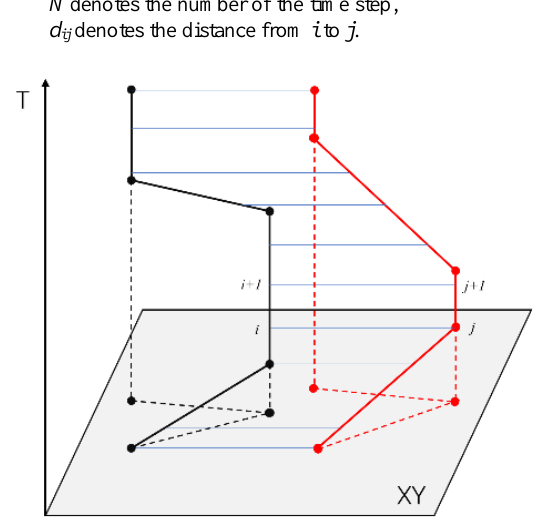
Figure 4. The similarity of